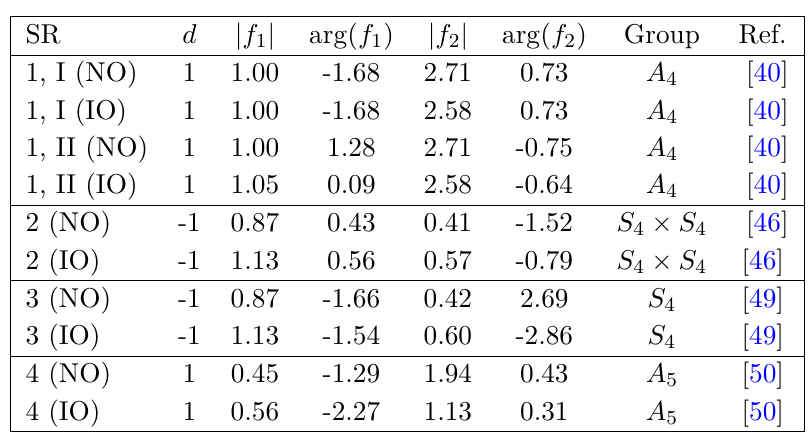
Table 1 . Overview of parameters entering the mass sum rule for the models we considered here. The values for | f i | and arg( f i ) are calculated with the best fit values of the underlying model parameters. However, it should be noted that for SR 1 cases I and II the mass sum rule cannot be fulfilled for the θ, φ at their best fit values in IO.